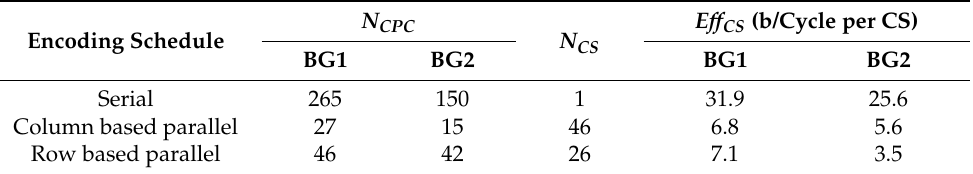
Table 1. Comparison of approximated hardware usage efficiencies of a flexible encoder for various encoding schedules and for the longest codeword ( Z = 384) in b/cycle per circular shifter used. Encoding Schedule